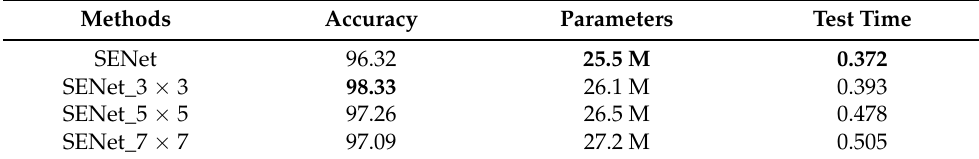
Table 2. Ablation studies applying different crossover window sizes to CroReLU on a private